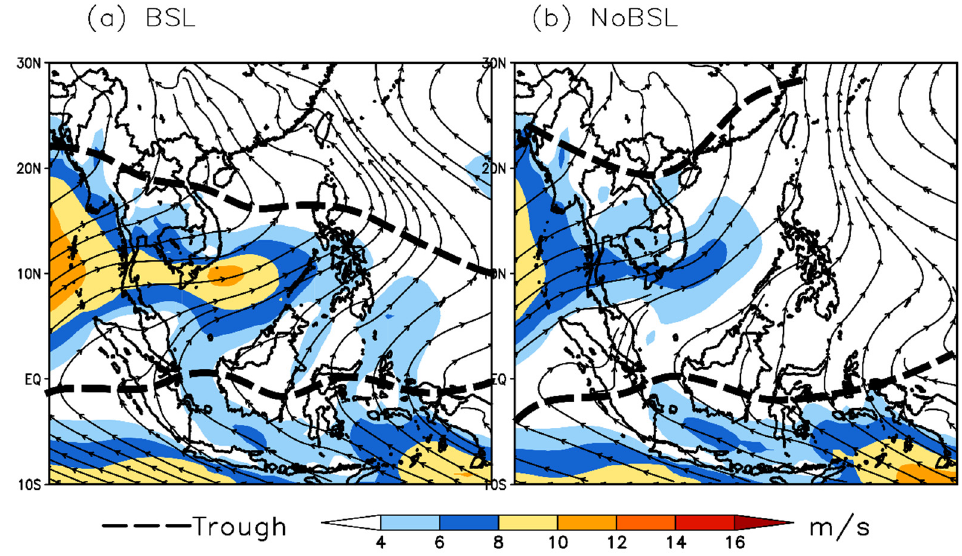
Figure 6. Composite 925-hPa daily wind streamline charts of all collected ( a ) BSL days; and ( b ) Non- BSL days from the year 1998 to 2018 (May–September). Blue to red shaded area indicates stronger wind speed, while monsoon trough is denoted by a black, thick-dashed line.